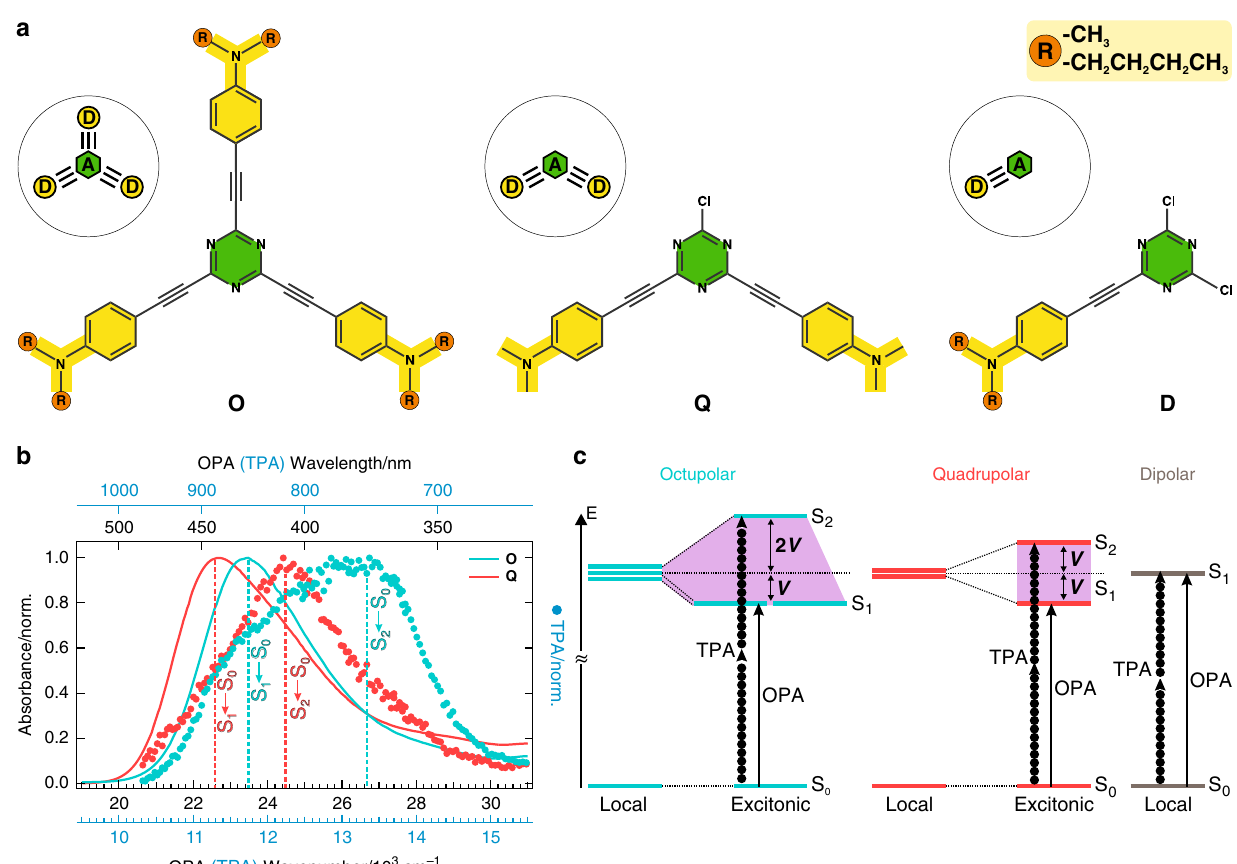
Fig. 1 Multipolar compounds and their absorption spectra interpreted with the Kasha excitonic model. a Structures of the triazine-based multipolar dyes O and Q along with the model dipolar analogue D . The electron-donating moieties ( D ) are in yellow and the acceptor ( A ) is in green, whereas R (orange) represents alkyl side chains. The butyl R groups make O and D soluble in alkanes. b One-photon (OPA, solid line) and two-photon (TPA, circles) absorption spectra of O (blue) and Q (red) in chloroform. TPA spectra correspond to blue axes, whereas OPA spectra are plotted on black axes, which are twice higher in energy. Dashed lines pinpoint the maxima of the dominant transition. c Illustration of the excitonic splitting for octupolar and quadrupolar systems within the Kasha exciton model, with the relation between the Davydov splitting (purple shading) and the electronic interbranch coupling, V , and the one- (solid arrows) and two-photon-allowed (arrows made of circles) transitions. The energy-level scheme of D is shown for